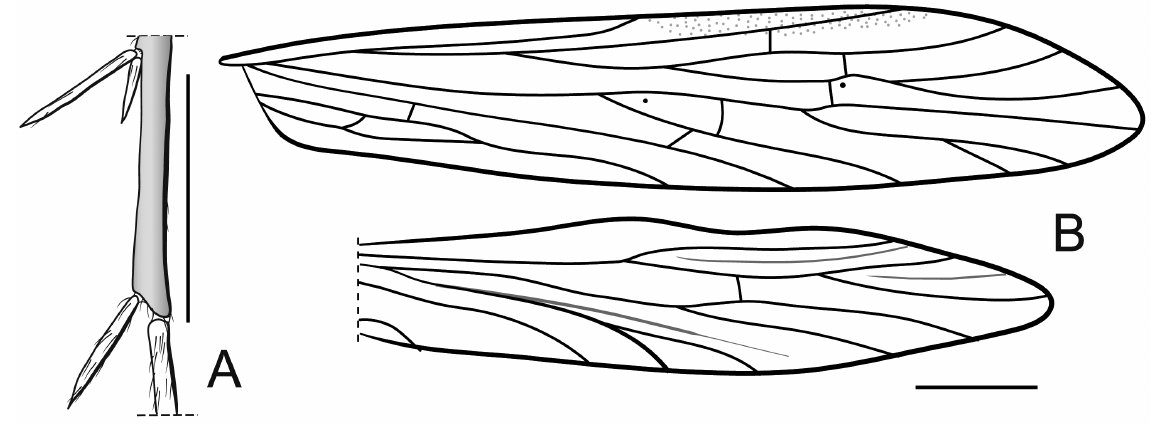
Fig. 6. Xiphocentron ( Antillotrichia ) redentor sp. nov., holotype, adult, ♂. A . Tibial spurs of the hind leg. B . Right wings, dorsal view. Scale bar = 0.5